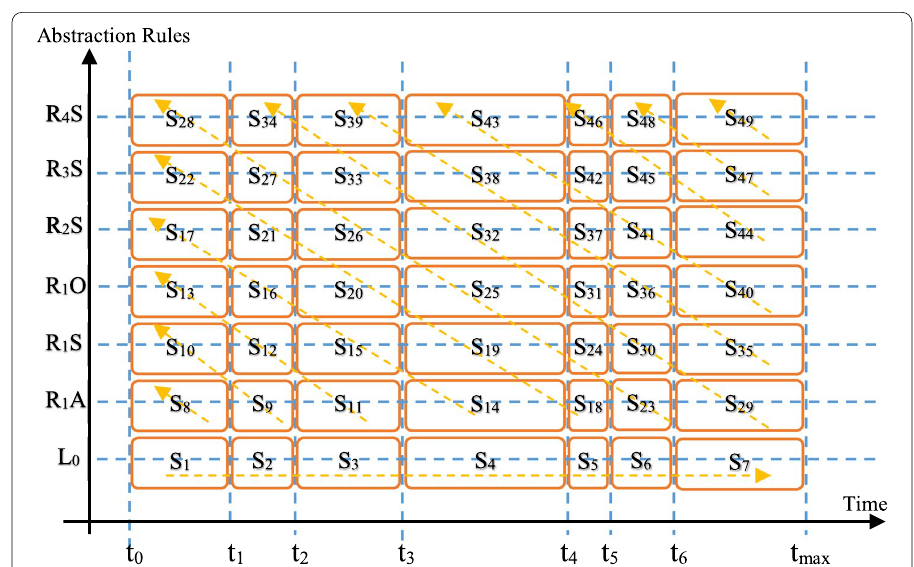
Fig. 11 Using less abstraction for the recent events and more abstraction for the old